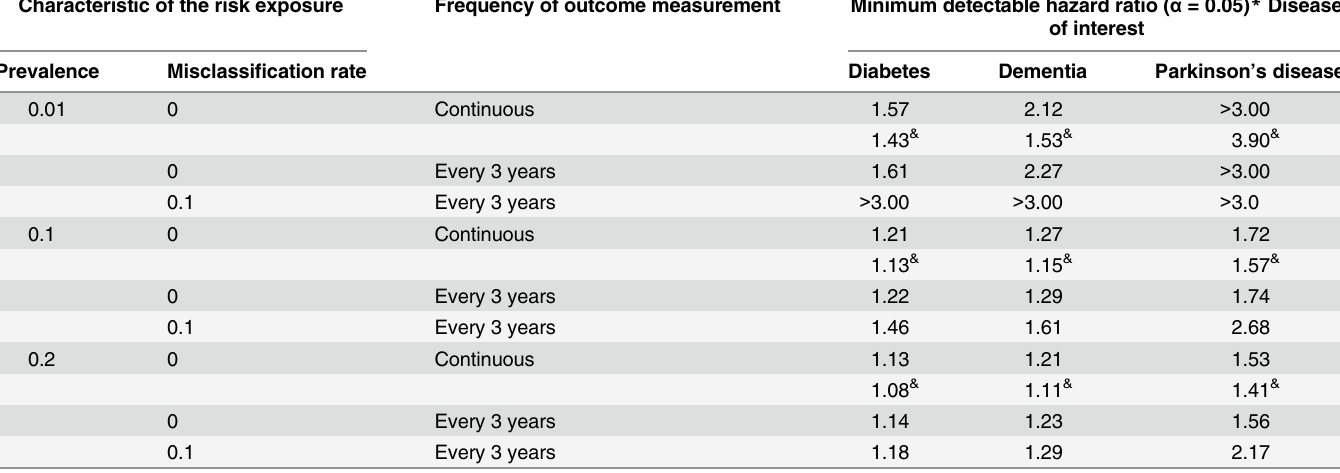
Table 1. Minimum detectable hazard ratio for environmental risk